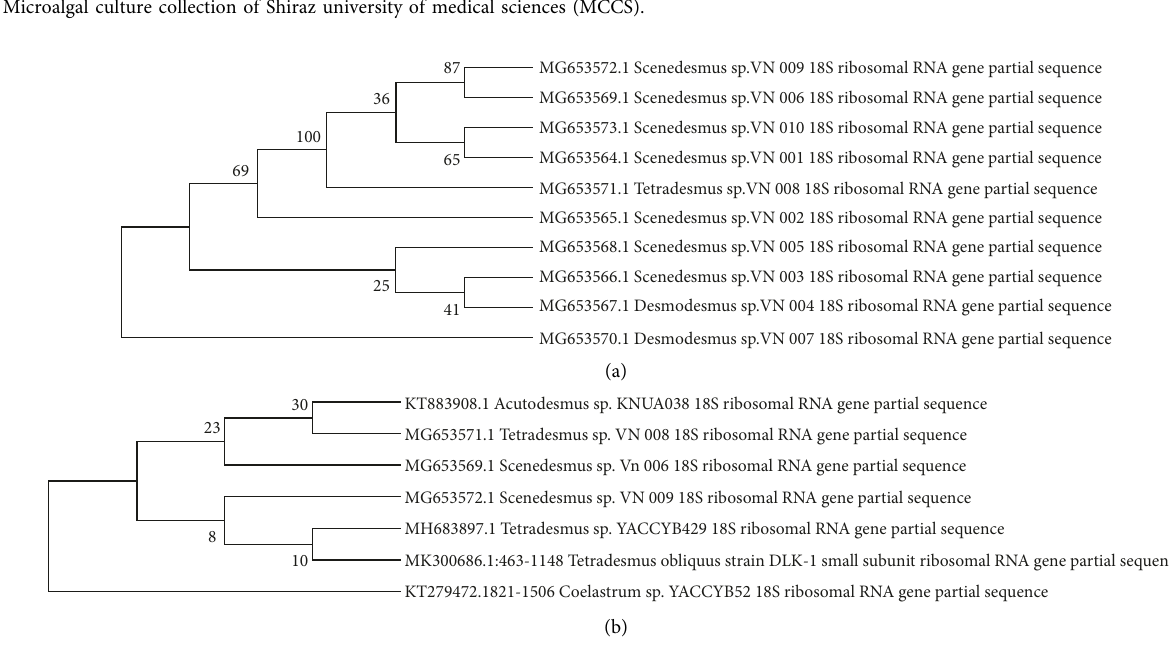
Figure 3: (a) Phylogenic analysis of ten microalgal isolates with higher biomass productivities using MEGA-X analyzed by maximum likelihood (distance measure Jukes-Cantor model, bootstrap 500 replicates) with nearest neighbor interchange. (b) Phylogenic tree of (cid:29) (cid:29) three promising strains ( Scenedesmus sp. VN009, Scenedesmus sp. VN006, and Tetradesmus sp. VN008) by compared with other closely related species using MEGA-X analyzed by maximum likelihood (distance measure Jukes-Cantor model, bootstrap 500 replicates) with (cid:29) (cid:29) nearest neighbor interchange.